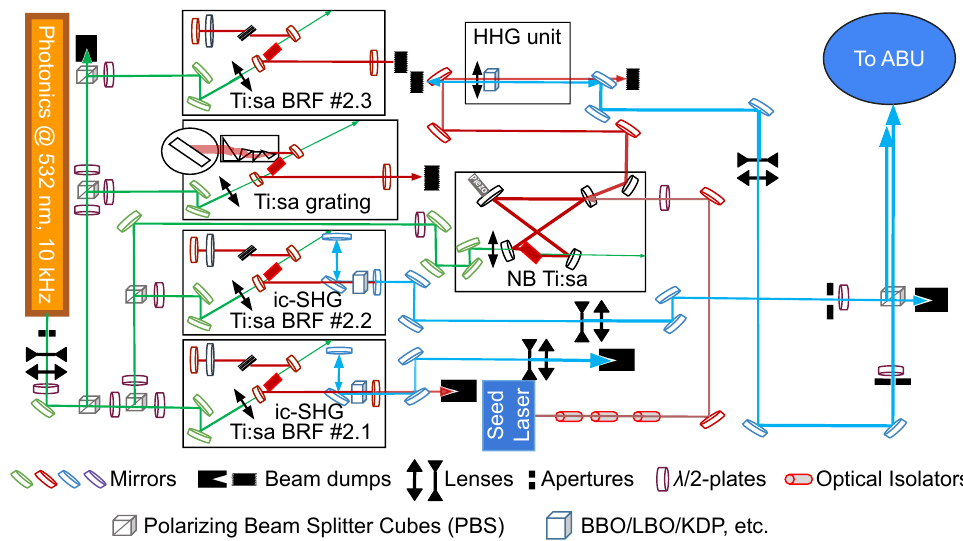
Figure 3. Typical GISELE laboratory layout. See text for